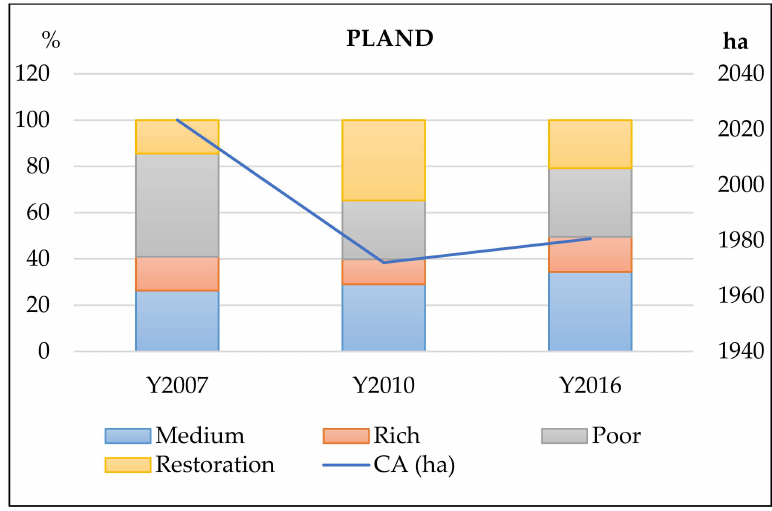
Figure 5. Variation of four forest types in the total class area of natural forest (CA_ha) and percentage of landscape (PLAND_%) for each forest type from 2007 to